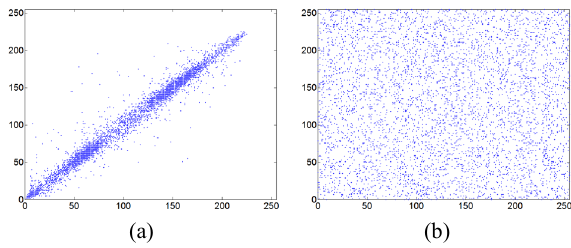
Fig. 4. (a) correlations of horizontally adjacent pixels in Fig. 3(a); (b) correlations of horizontally adjacent pixels in Fig. 3(c).